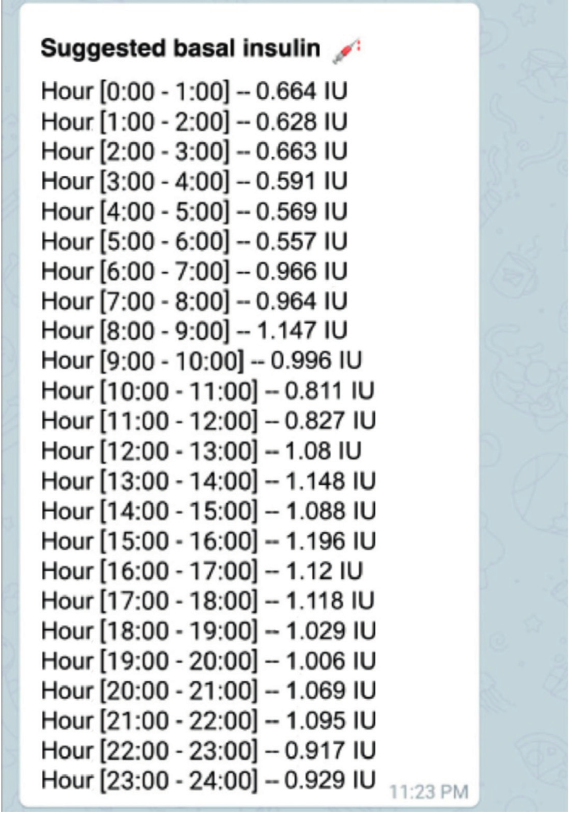
Figure 5: Example of basal dose insulin created by